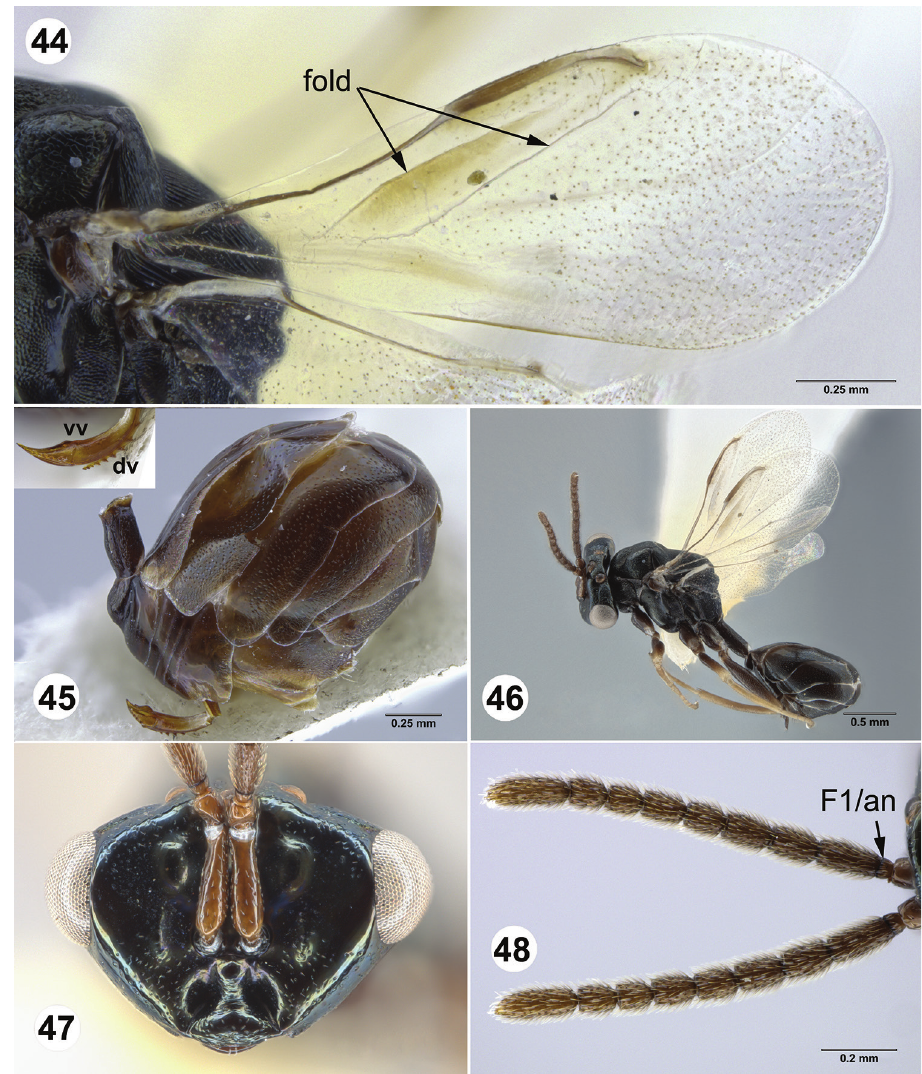
Figures 44–48. Ivieosema confluens . Paratype female: 44 fore wing 45 metasoma, lateral, lateral view of ovipositor in top left corner. Holotype male: 46 habitus, lateral 47 head, anterior 48 antennae, dorsal. dv = dorsal (2 nd ) valvula, F1/an = anellus; vv = ventral (1 st ) valvula. transepimeral sulcus. Propodeum finely reticulate, callus bare and smooth to shallowly reticulate. Metacoxa smooth. Fore wing 2.3× as long as broad; slightly infuscate along cubital fold and posterior to marginal and submarginal veins, and between the oblique folds in the speculum; venation with only a few tiny setae, including on submarginal vein; costal cell bare; basal cell bare; speculum present, with two oblique folds (Fig. 44, fold) that converge towards stigma and basal fold; marginal vein very thick basally